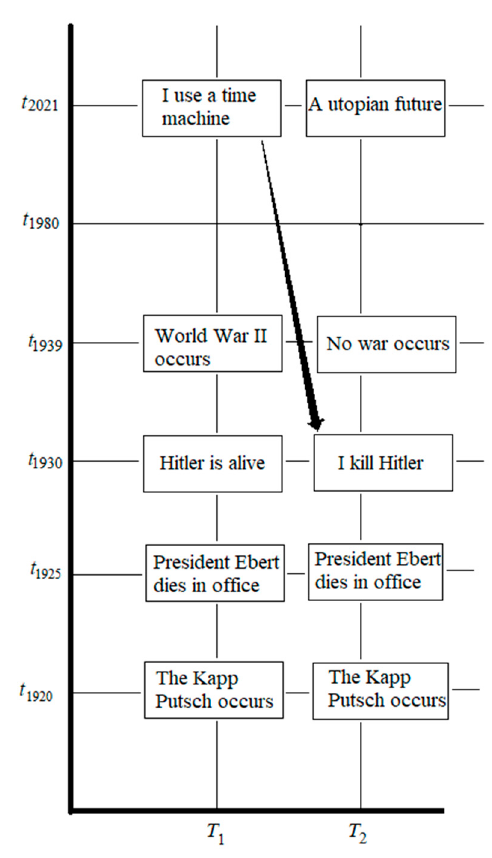
Figure 1. Exterminous hypertime and time travel.